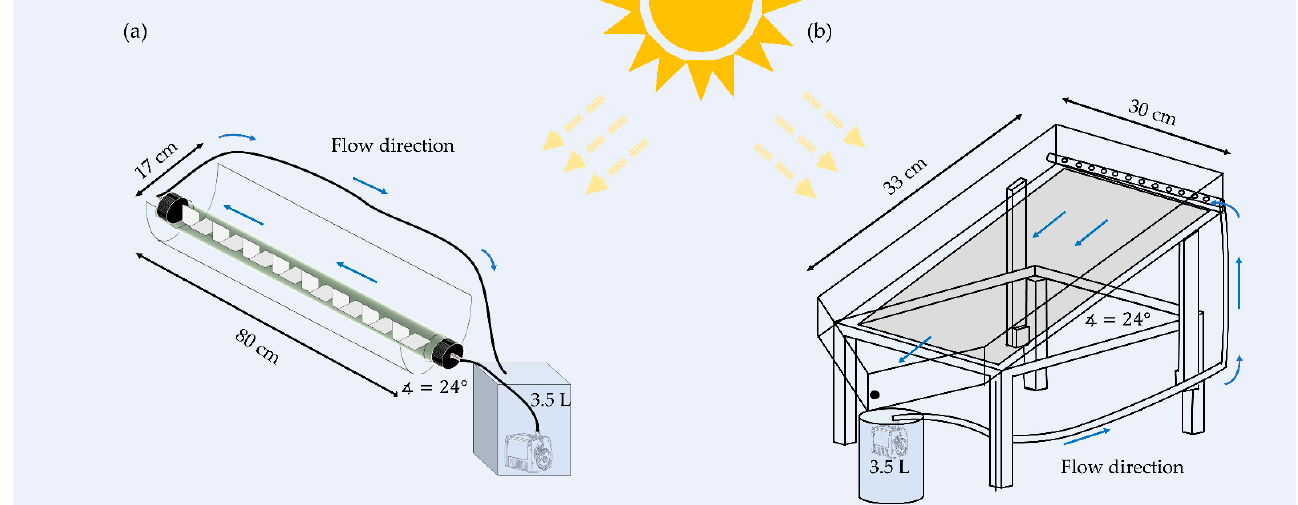
Figure 3. Experimental setup and reactor schematics: ( a ) CPC reactor ( b ) FPR reactor.